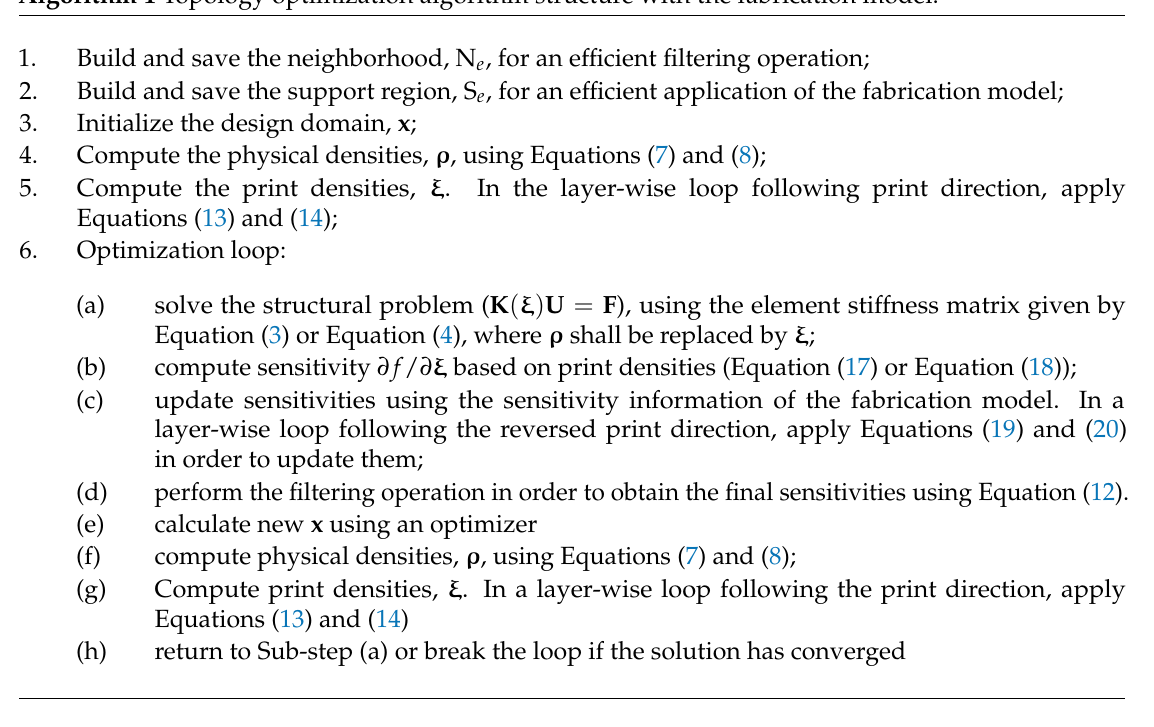
Algorithm 1 Topology optimization algorithm structure with the fabrication